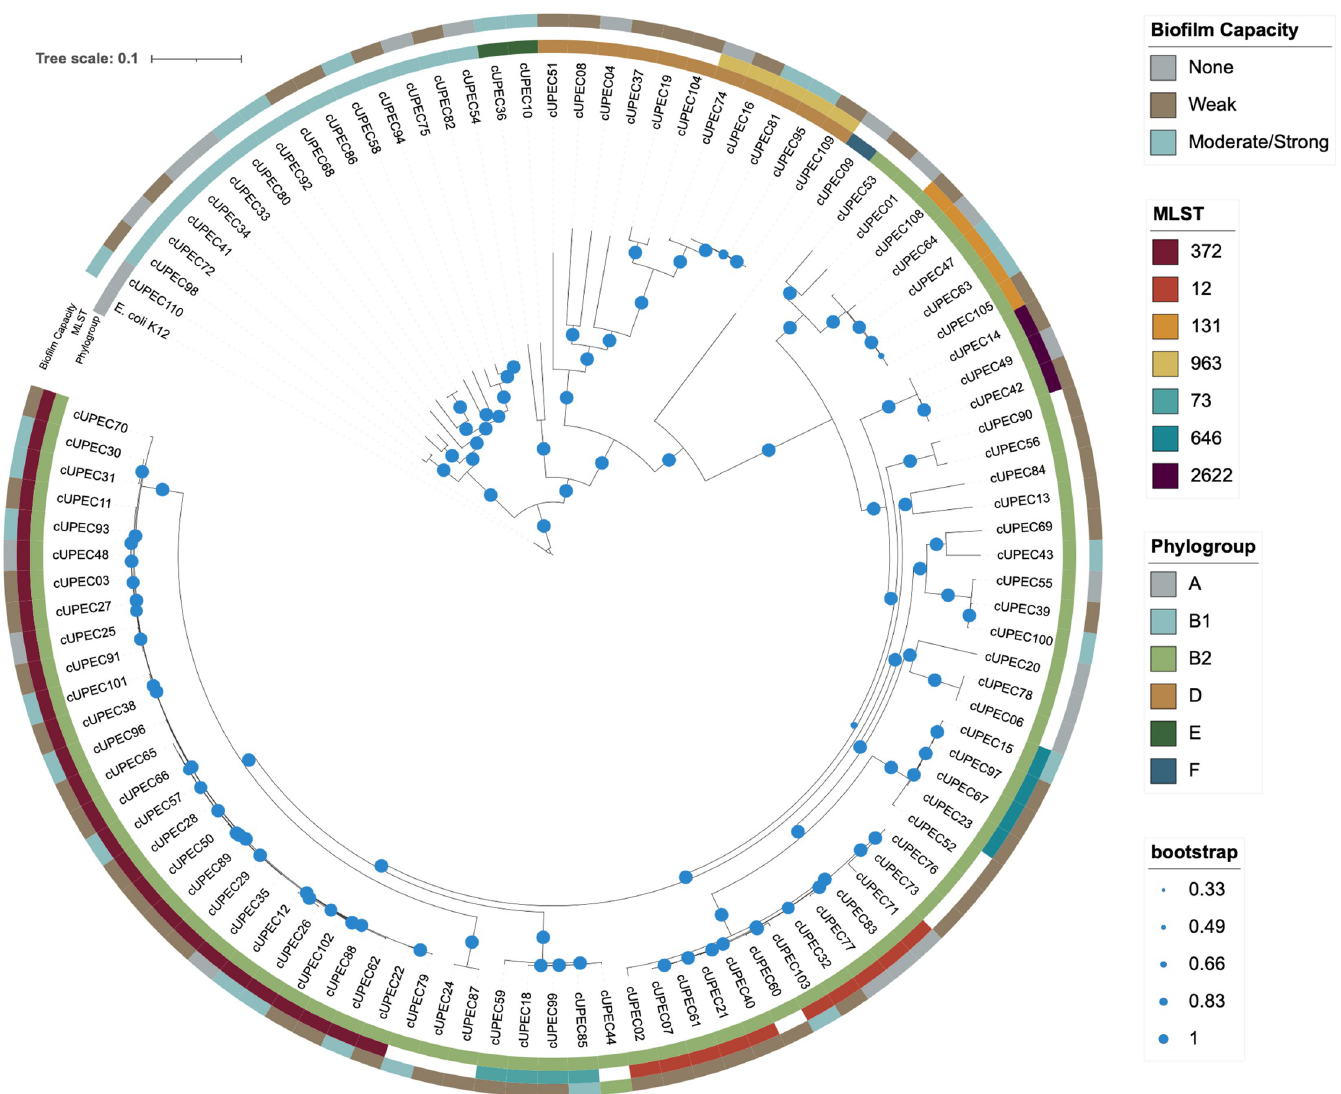
Fig 1. Maximum likelihood tree of 104 canine UPEC isolates. Maximum likelihood phylogenetic tree of core SNP variation among 104 canine UPEC isolates and their associated phylogroup (innermost ring), most frequent MLST sequence types (middle ring), and biofilm capacity (outermost ring). Biofilm formation was categorized (none, weak, moderate/strong) based on a qualitative scale separated by specific optical density value cut-offs.